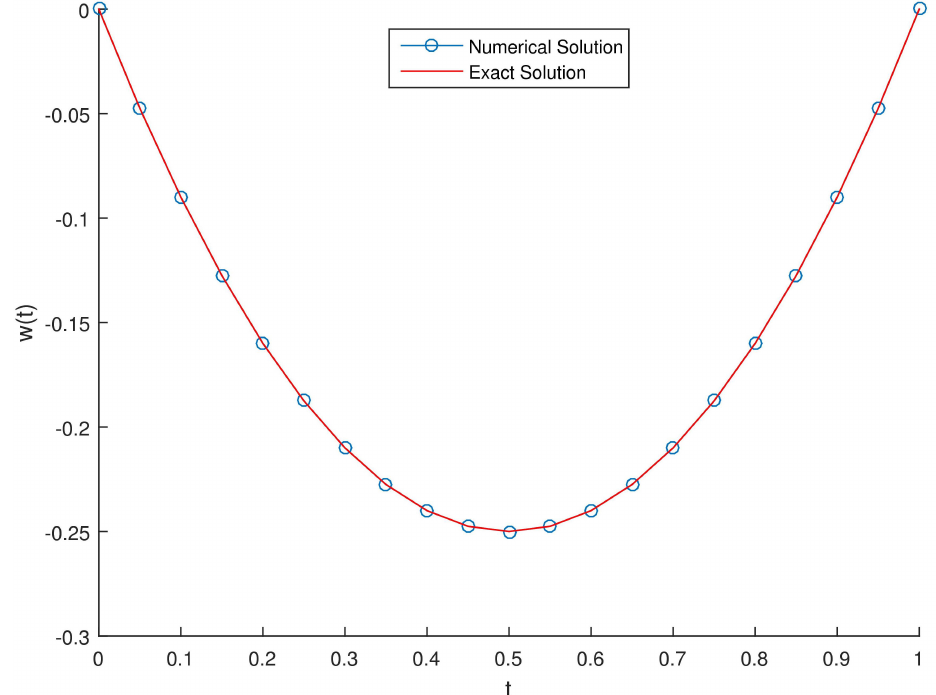
Figure 4. The behaviour of approximate and exact solutions for Example 2 with τ =